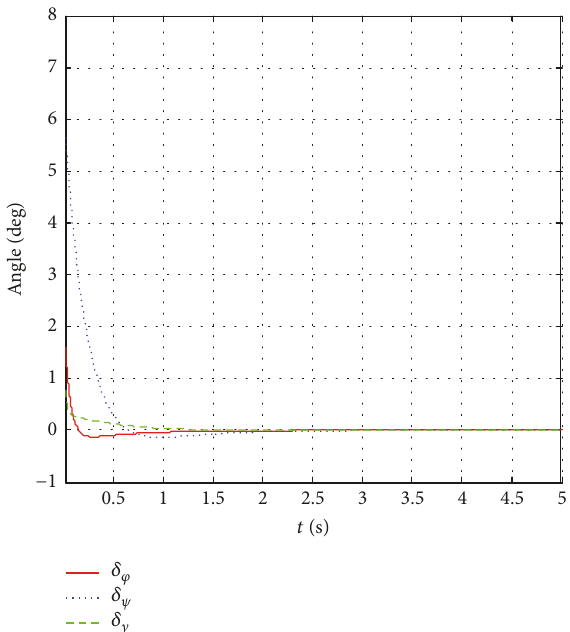
Figure 3: Regulating process of rudder angles as control inputs.